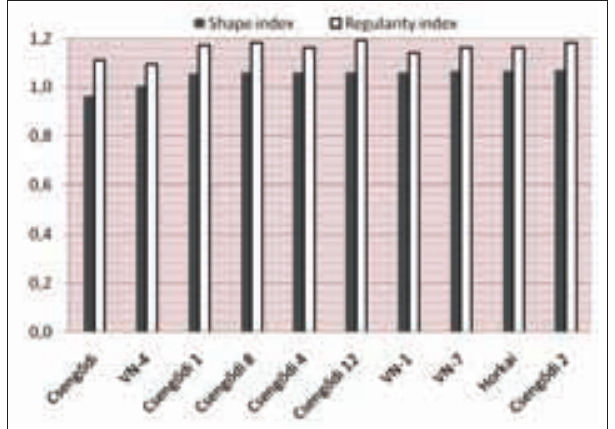
Figure 1. Shape and regularity index of resistant sour cherry clones (Pallag-Újfehértó,